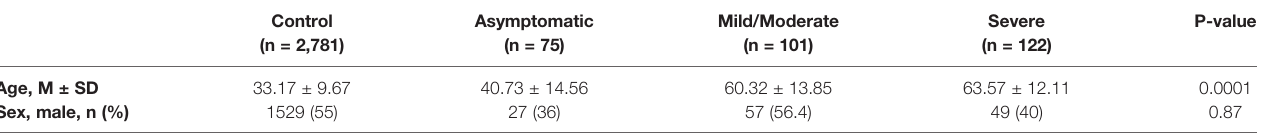
TABLE 1 | Demographic characteristics of patient subgroups and